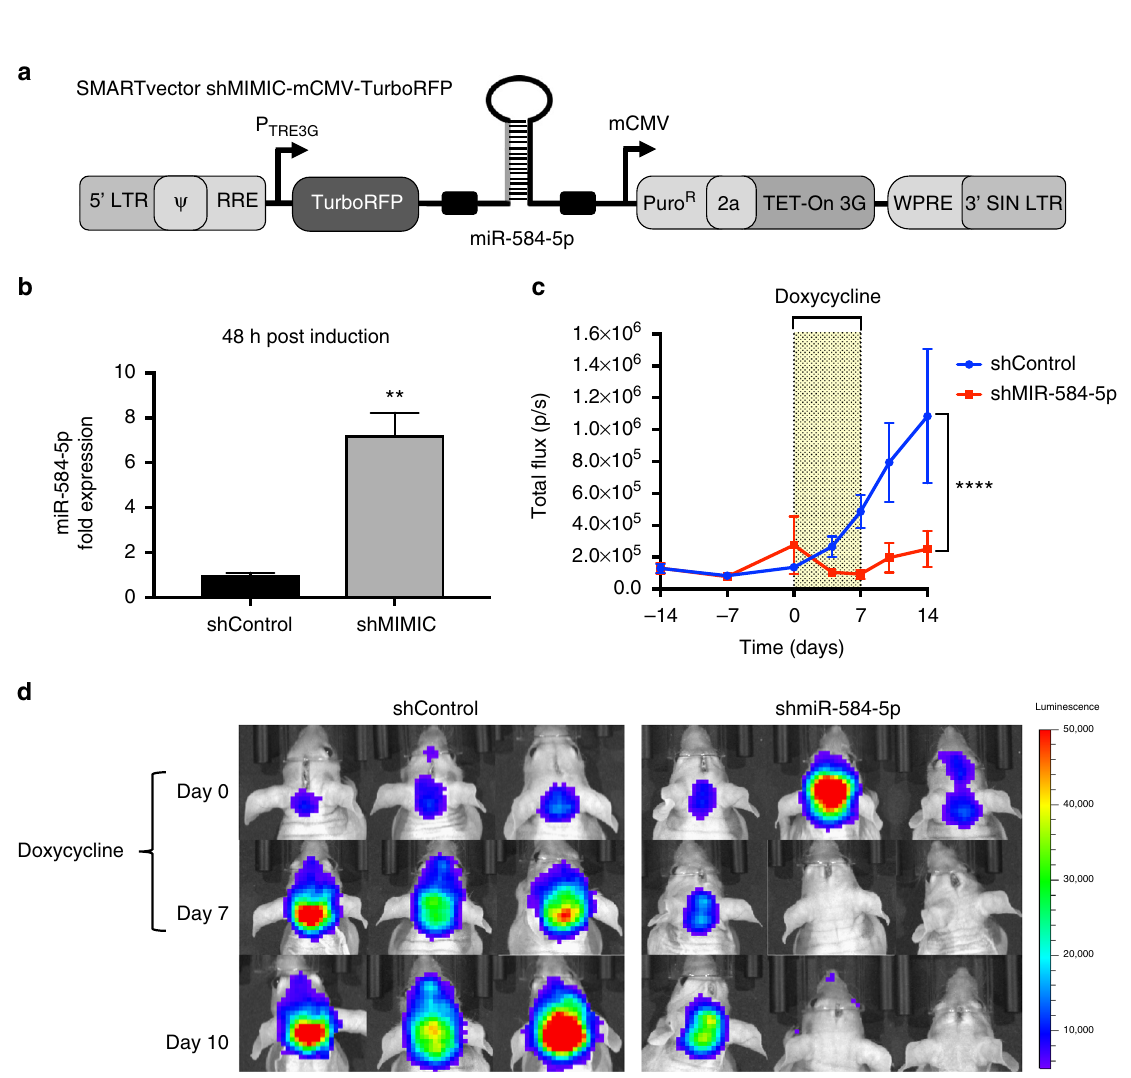
Fig. 3 m iR-584-5p inhibits MB growth in vivo. a Schematic of inducible miR-584-5p lentiviral construct. b qPCR analysis of miR-584-5p levels in DAOY – GFP – Luciferase cells stably transfected with shcontrol mimic or shmiR-584-5p mimic-TurboRFP vector and treated with doxycycline using miR-584- 5p-speci fi c taqman probe. Error bars represent mean ± SEM of three independent experiments. The p -values were calculated using standard Student t - tests. c Line graphs showing tumor growth in athymic nude mice intracranially transplanted with DAOY – GFP – Luciferase cells stably transfected with inducible shcontrol mimic or sh miR-584-5p mimic-TurboRFP vectors ( n = 7/group). Dotted line represents duration of doxycycline treatment to induce scrambled and miR-584-5p expression. The p -values were determined by the sum-of-squares F test. Error bars represent mean ± SEM. d Live bioluminescence (BLI) images of mice intracranially transplanted with DAOY – GFP – Luciferase cells transfected with inducible shcontrol mimic or sh miR- 584-5p mimic-TurboRFP vector and treated with